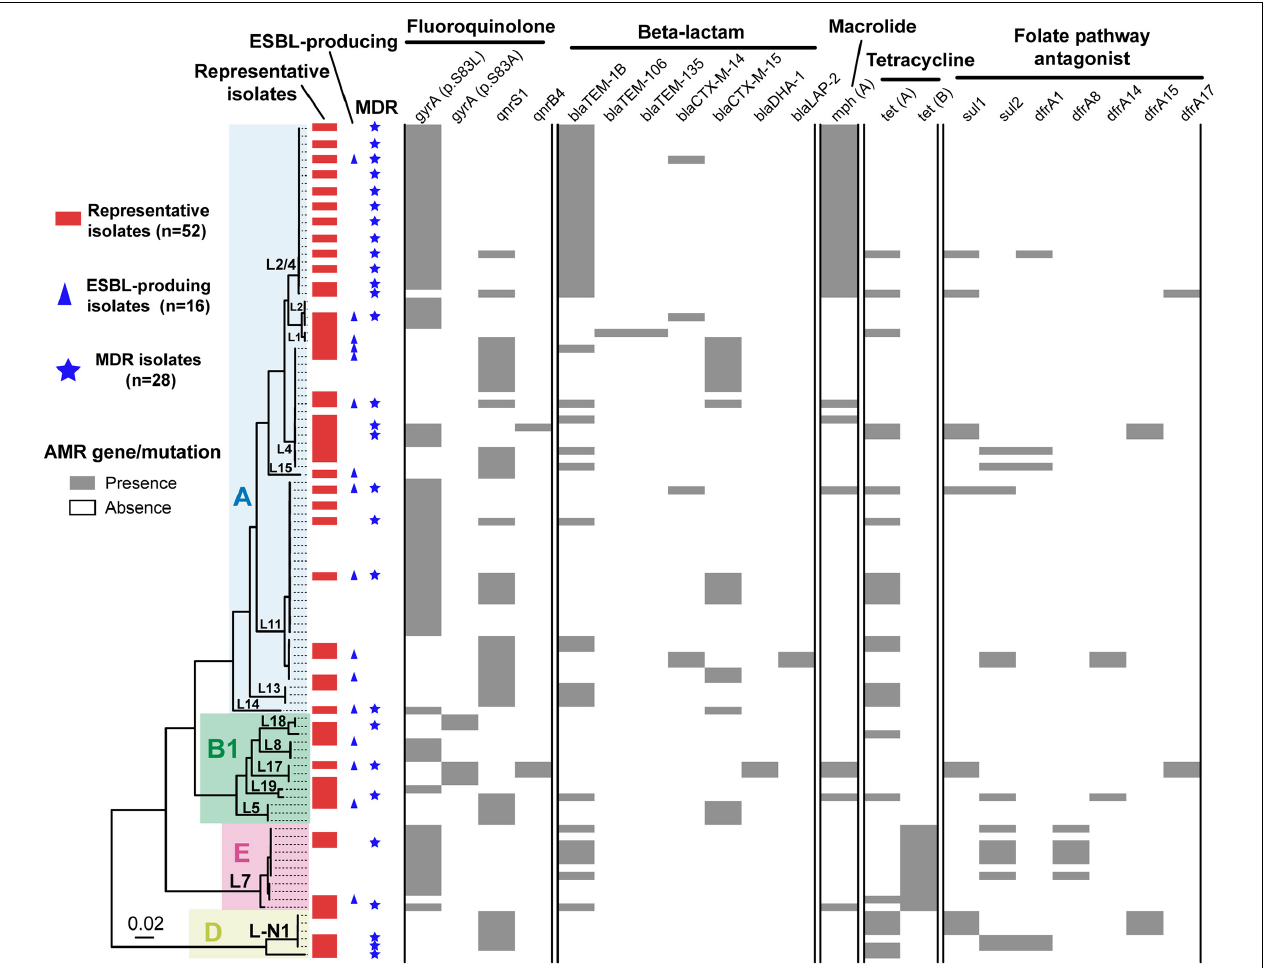
FIGURE 3 | Antimicrobial resistance related mutation and gene distribution in Shenzhen isolates. Maximum likelihood tree of 106 Shenzhen isolates was shown on the left, and the background colors indicated the E. coli phylogroups as in Figure 1 . The distribution of representative isolates for phenotype testing (red bars), extended-spectrum β -lactamase (ESBL)-producing isolates (blue triangles), multidrug-resistant (MDR) isolates (blue stars), and the presence (gray bars) or absence (white bars) of antimicrobial resistance related mutation and gene were shown on the